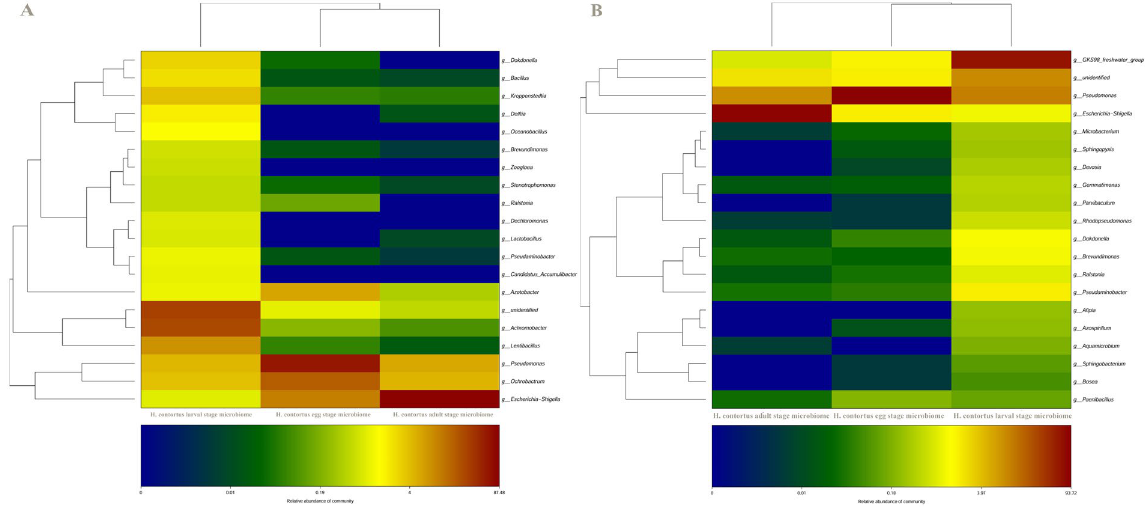
Figure 11. Double hierarchical dendrogram of the top 50 ranked H. contortus microbiota showing the relative abundance of the bacterial community at the genus level for different life-cycle stages of H. contortus using primer pairs targetingV3–V4 ( A ) and V4–V5 ( B ) regions. The relative values for bacterial species are depicted by color intensity, with legend indicated at the bottom of the figure. Data represent average values from pooled populations (i.e. from each sheep) of eggs/larvae/adults (male and female) come from three different